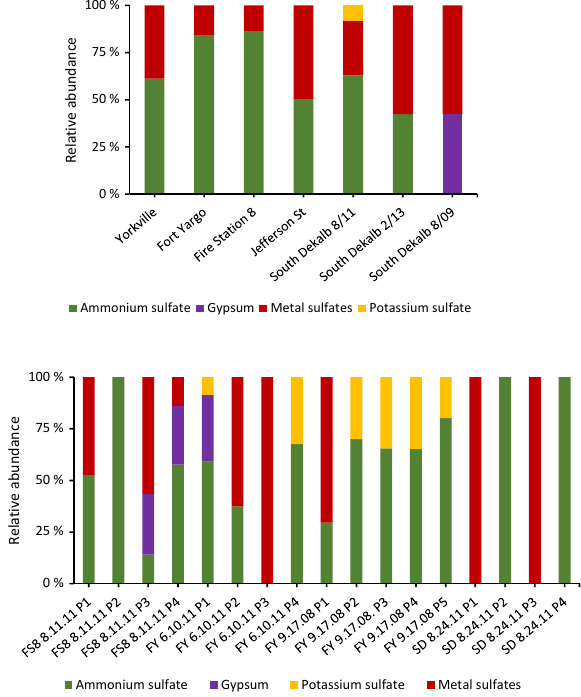
Figure 4. Composition of aerosol sulfate. Bulk (top) and individual particle (bottom) composition of sulfur in ambient particulate mat- ter. For bulk samples, the composition of sulfate was consistent for all samples within a particular sampling location, with the exception of South DeKalb. These samples had three different compositional groups, and the month and year of collection are provided next to the samples. For individual particles, the sulfate composition was able to be determined for samples from Fire Station 8 (FS8), Fort Yargo (FY), and South DeKalb (SD). Different particles from the same samples are numbered sequentially